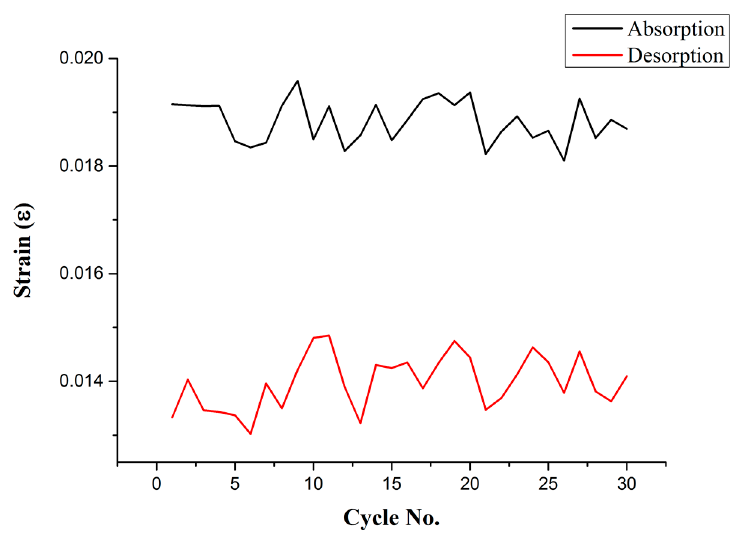
Figure 7. Maximum strain value of hydrogen storage tank for 30 cycles of hydrogen absorption and desorption.